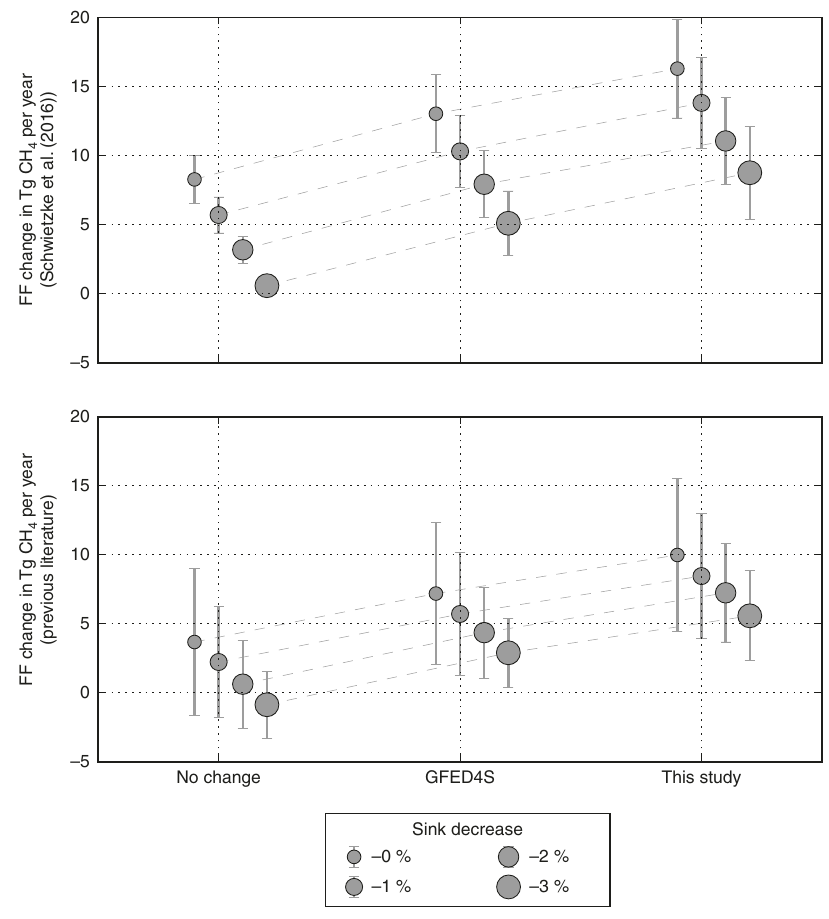
Fig. 5 Fossil fuel change needed to fi t the observed CH 4 growth rate and isotopic composition. Fossil fuel change needed to fi t the observed CH 4 growth rate and isotopic composition assuming a simultaneous change in the CH 4 lifetime due to a change in sink. The results for a constant (0%) sink change correspond to the iso-mf scenario (red lines in Fig.